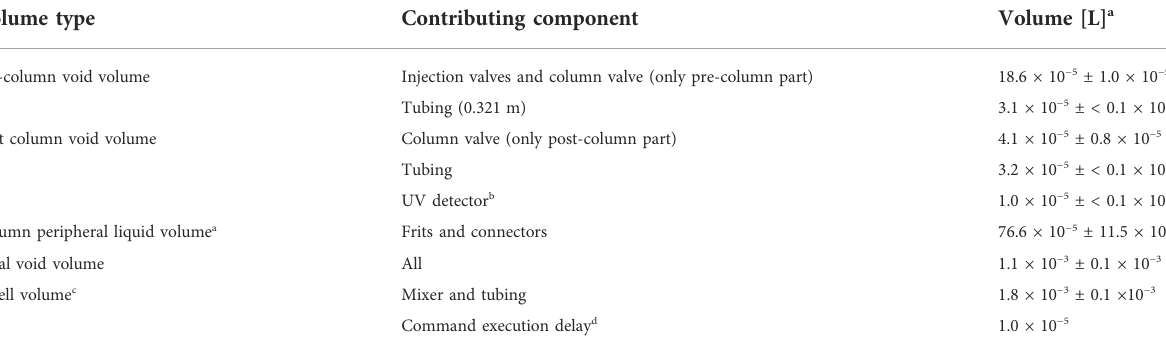
TABLE 3 Examples of system and column peripheral liquid volume as determined for an ÄKTA pure 25 L (nonstandard equipment: column valve kit V9-C and 5 mm UV fl ow cell) system equipped with an XK16/20 column (16 mm diameter, maximum bed height 200 mm). Volume type